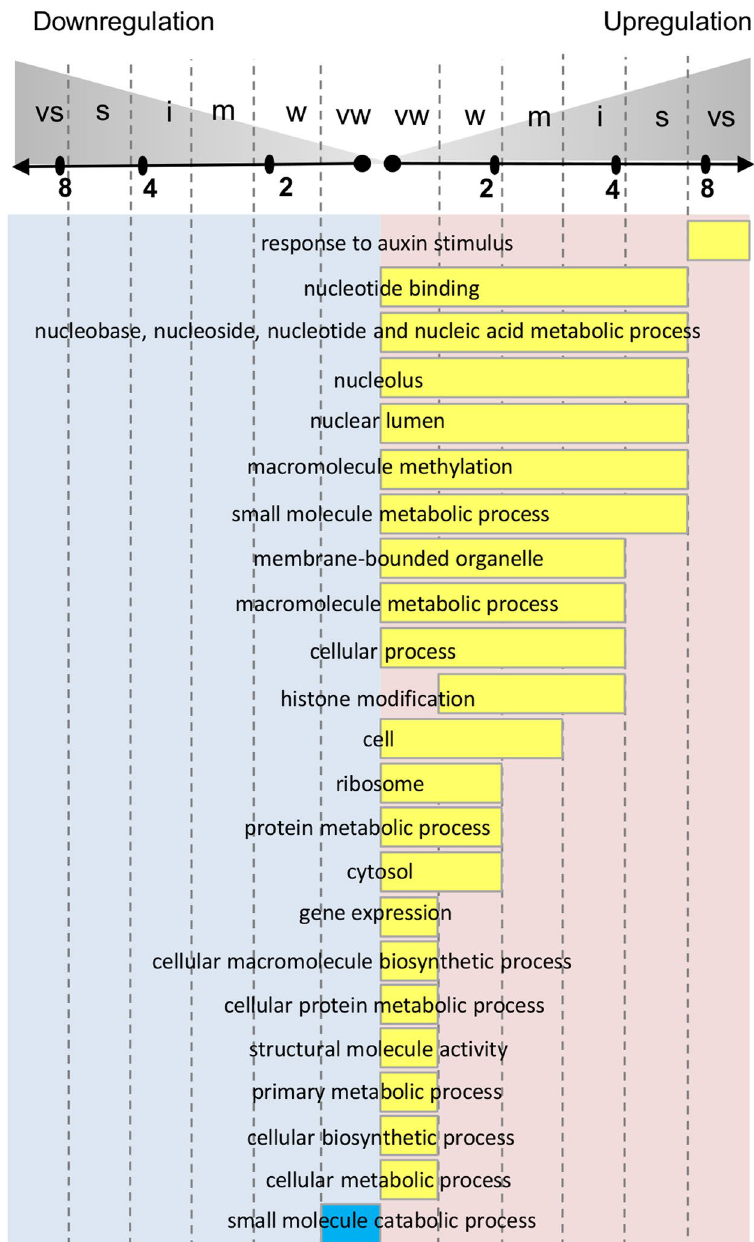
and are designated in Figs 2 and 4. For details see Supplementary Tables 6 and